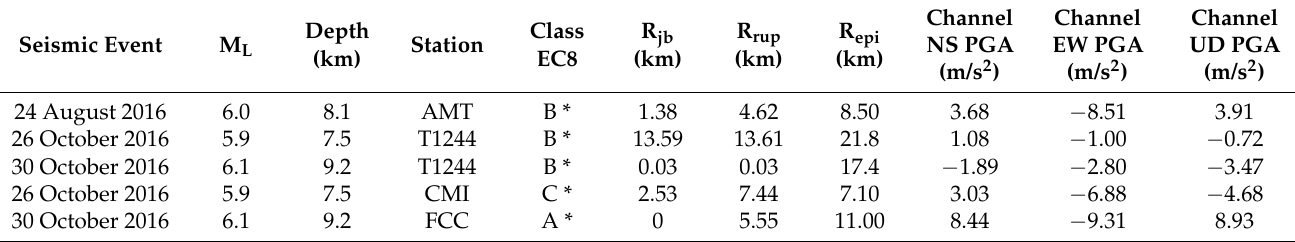
Table 3. Characteristics of main earthquakes recorded in Amatrice (AMT), Spelonga (T1244), Campi (CMI), and Forca Canapine (FCC) stations during the main seismic events of the last few decades in Italy, where * indicates that site classification is not based on a direct V s,30